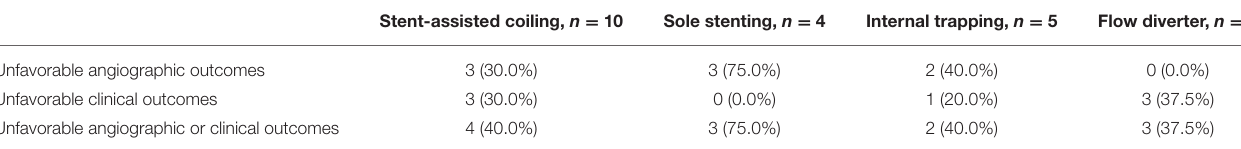
TABLE 2 | Comparison of unfavorable outcomes with different treatments for giant vertebrobasilar aneurysms. Stent-assisted coiling, n = 10 Sole stenting, n = 4 Internal trapping, n = 5 Flow diverter, n = 8 Unfavorable angiographic outcomes 3 (30.0%) Unfavorable clinical outcomes Unfavorable angiographic or clinical